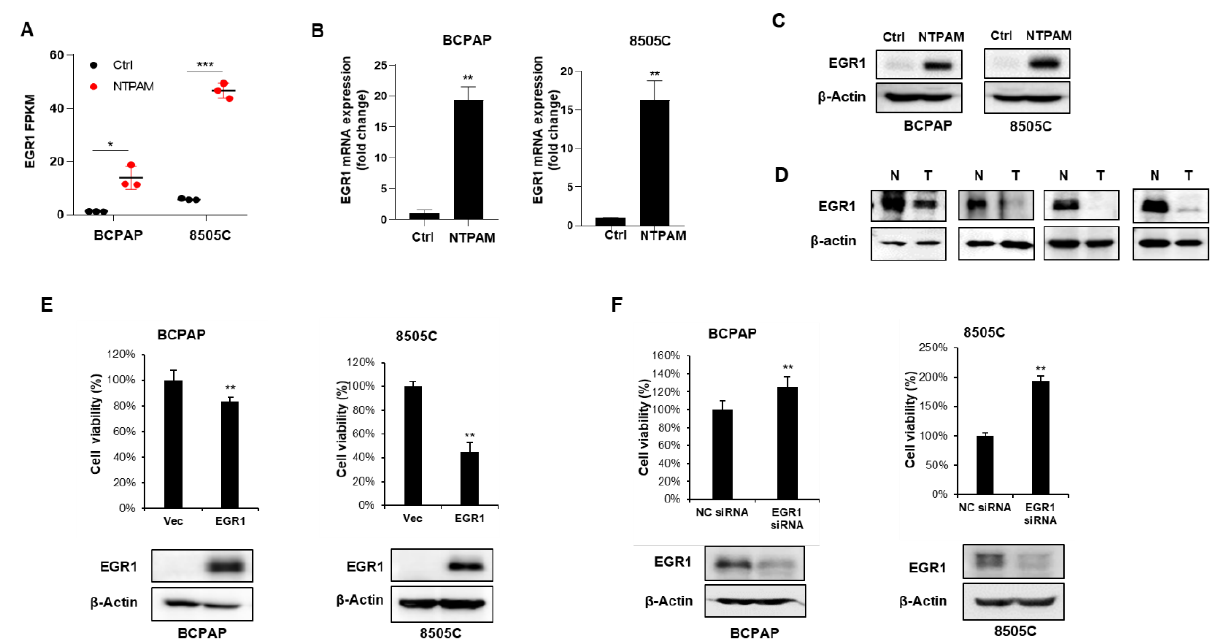
Figure 4. NTPAM-induced EGR1 inhibits THCA cell viability. ( A ) Changes in EGR1 expression after NTPAM treatment, as determined by RNA-seq. Results were analyzed using independent t -test. After 2 h dose-NPTAM treatment for 24 h, the EGR1 expression was examined by quantitative PCR (qPCR) analysis ( B ) and western blot analysis ( C ). Results were analyzed using Mann-Whitney U test. ( D ) Tissue samples obtained from patients with THCA were examined using western blot analysis with an anti-EGR1 antibody. ( E ) BCPAP and 8505C cells were transiently transfected with an EGR1 overexpression vector or a negative control vector for 48 h. Cell viability was analyzed by cell-counting analysis. Results were analyzed using Mann-Whitney U test. ( F ) BCPAP and 8505C cells were transiently transfected with EGR1-specific siRNA or negative control siRNA for 48 h. Cell viability was analyzed by cell-counting analysis. Results were analyzed using Mann-Whitney U test. Each figure is representative of three independent experiments. Data were expressed as mean ± standard deviation of the mean (±SD). Differences were considered relevant at p < 0.05 (* p < 0.05, ** p < 0.01, *** p < 0.001).